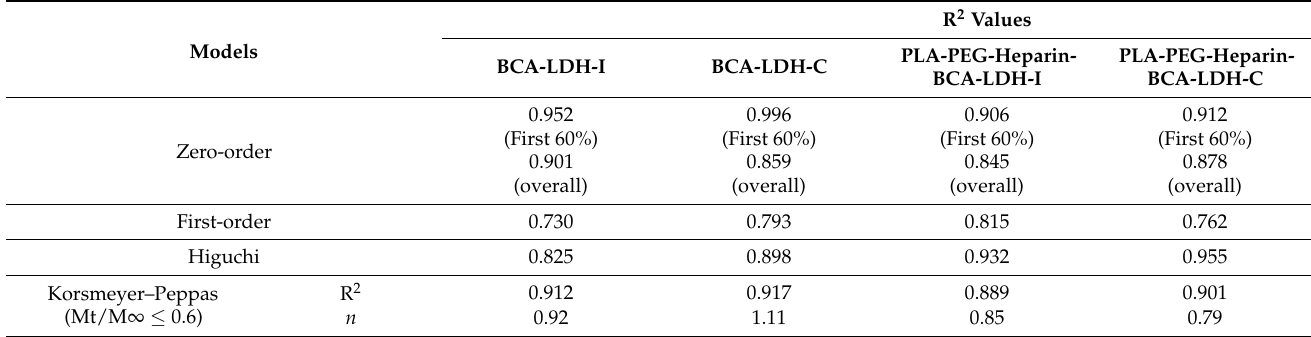
Table 1. Regression coefficients (R 2 ) obtained by fitting of drug release in kinetic models.